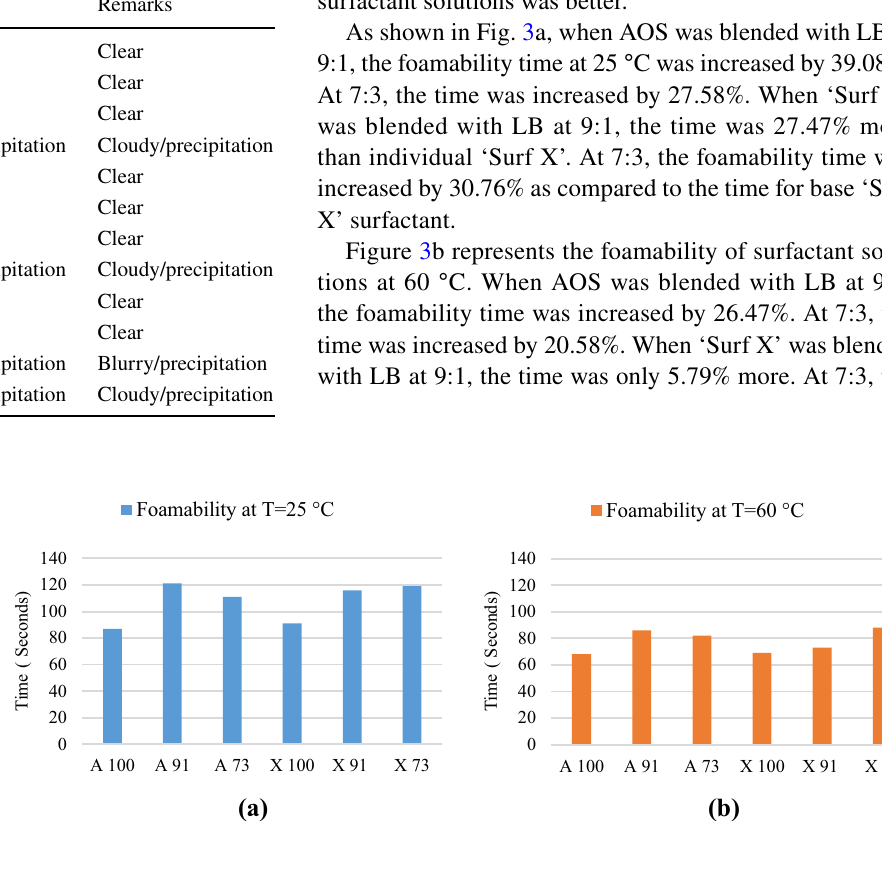
Table 2 Aqueous solution stability results of the surfactant solutions tested at 25 °C and 60 °C Sample no.